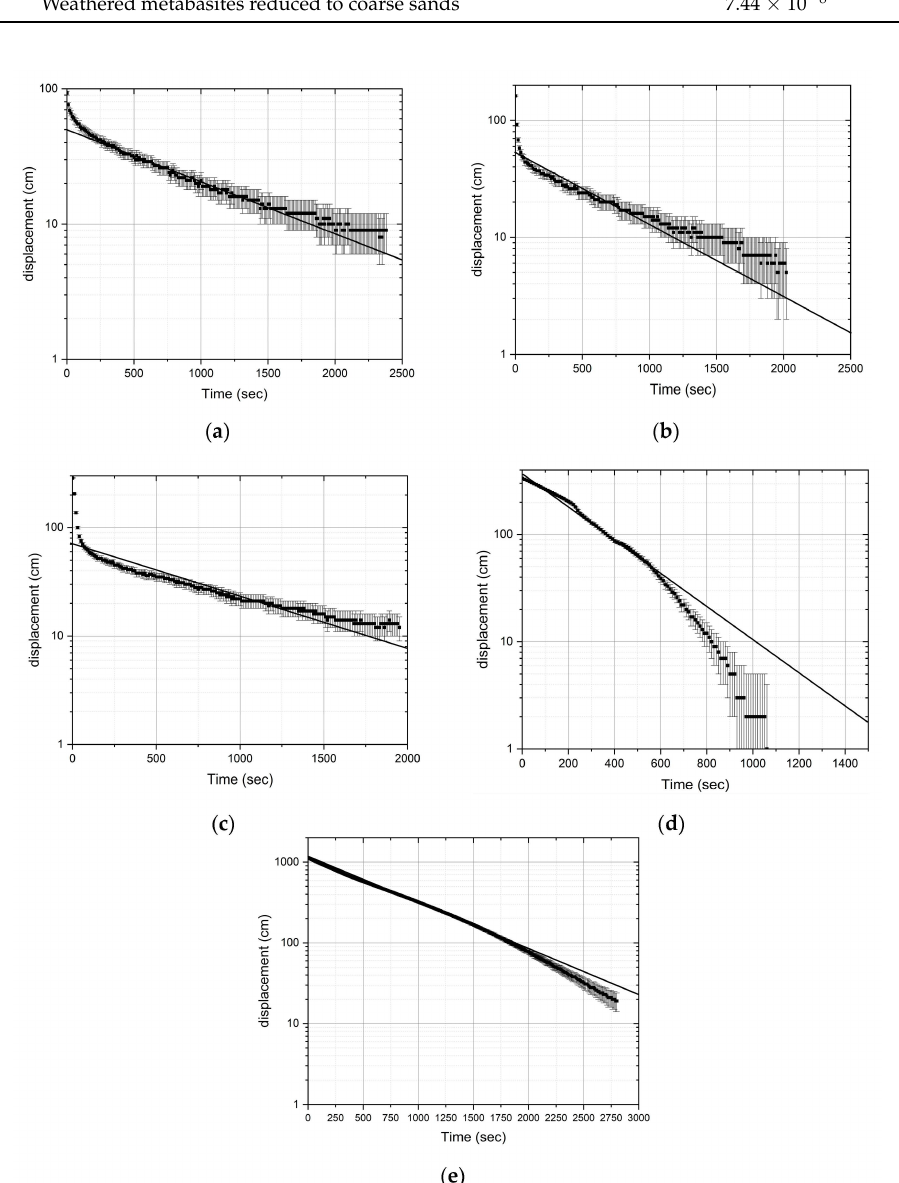
Figure 6. Logarithm of hydraulic head displacement (H) and measurement error bars vs. time plot of slug tests performed in boreholes S2a ( a ), S2b ( b ), S2c ( c ), S3b ( d ), and S3c ( e ) at the Gimigliano study